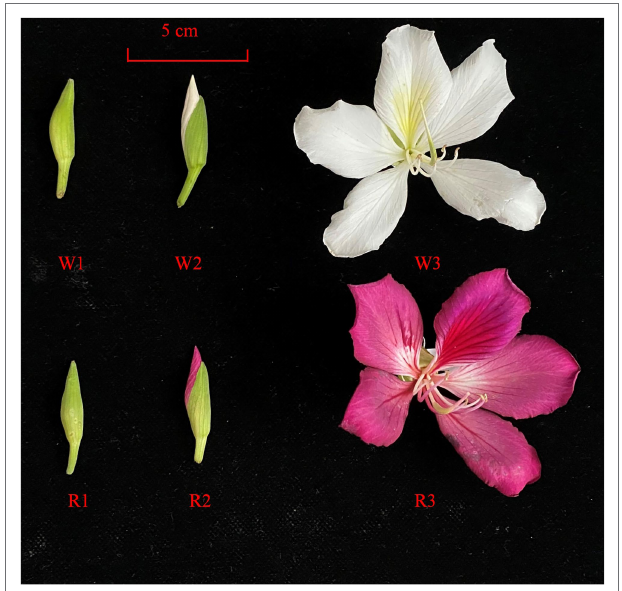
FIGURE 1 | Bauhinia variegata in the early (W1, R1), middle (W2, R2), and blooming stages (W3, R3) in white (W) and red (R)